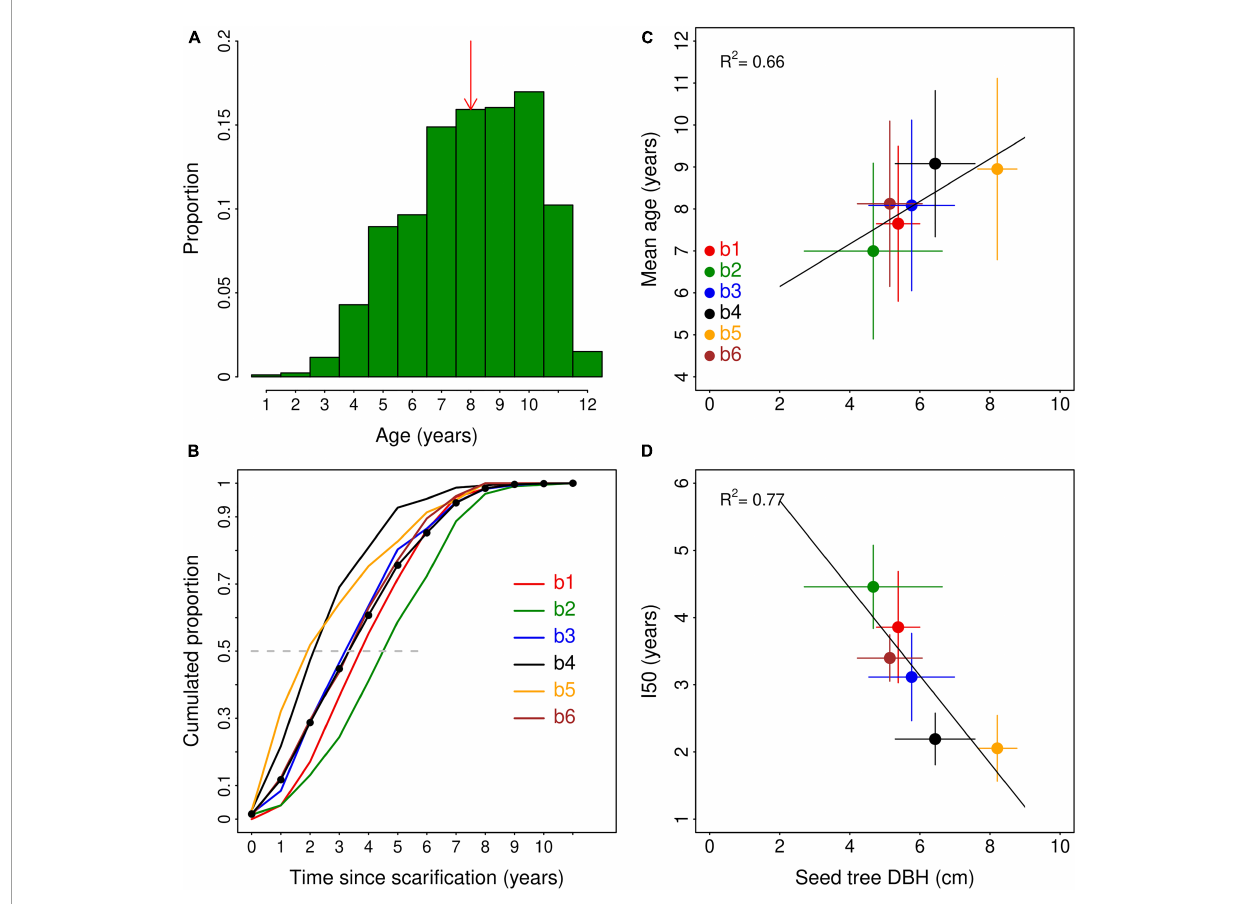
FIGURE4 Left panels. (A) Age structure of the 860 seedlings analyzed the six sites. The red arrow indicates the median age value; (B) seedlings’ establishment rate during the 11 years following soil scarification. The dotted line shows the mean values across the six sites. Right panels. Relationships between seed tree mean DBH (cm) and (C) mean age of seedlings; ( y = 6.1 + 0.33 x) and (D) the establishment time index [i.e., the time (years) since scarification to reach 50% of final the seedling density] ( y = 7.05–0.65 x). R 2 and P -values are shown for the linear regression conducted on plot values.